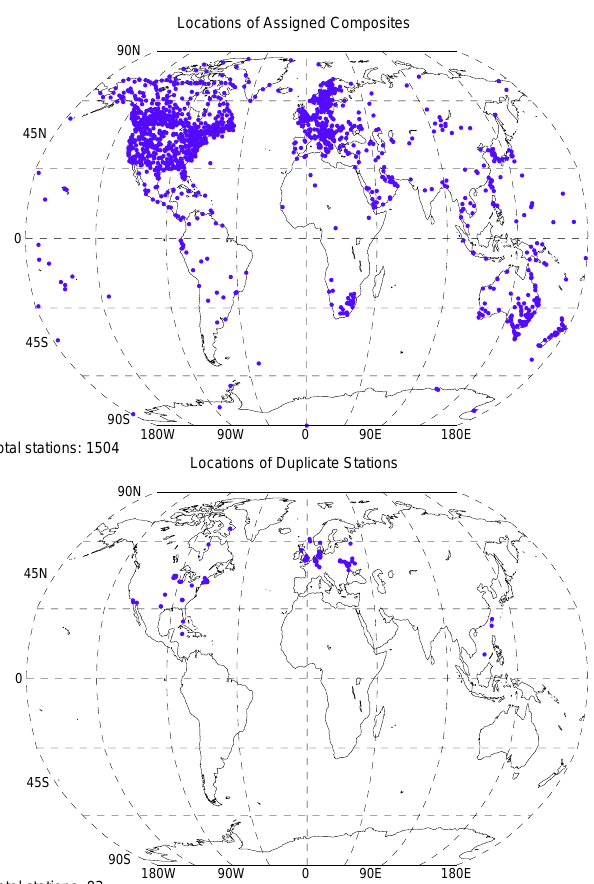
Fig. 1. Top: locations of assigned composite stations from the ISD database before any station selection and filtering. Only 943 of these 1504 stations were passed into the QC process. Bottom: locations of 83 duplicated stations identified by the inter-station duplicate check (Sect. 4.1.1, test 1.)